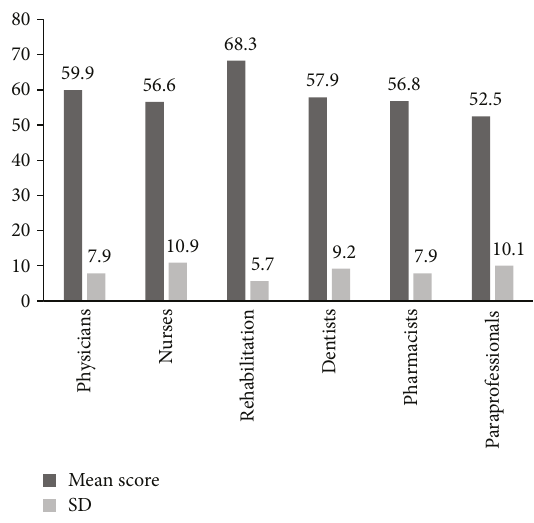
Figure 4: Mean scores and standard deviations of healthcare personnel